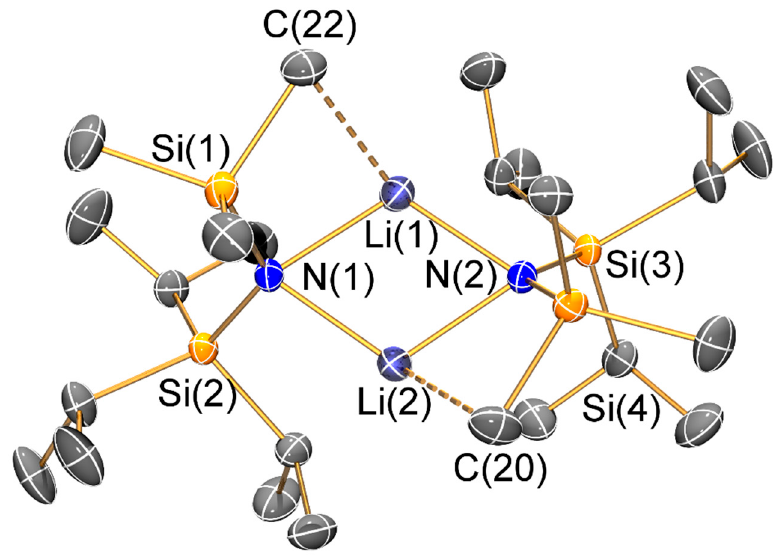
Figure 4. Molecular structure of [Li{ μ -N(Si i Pr 3 )(SiMe 3 )}] 2 ( 3 ) with selective atom labelling. Displacement ellipsoids set at 30% probability level and hydrogen atoms omitted for clarity.